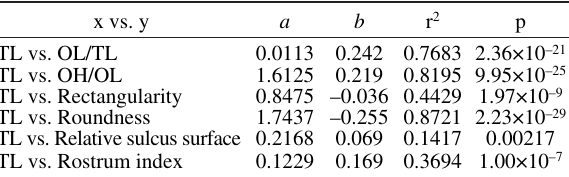
Table 2. – Probability values (p) obtained from a post-hoc Mann- Whitney test (with Bonferroni correction) in order to detect